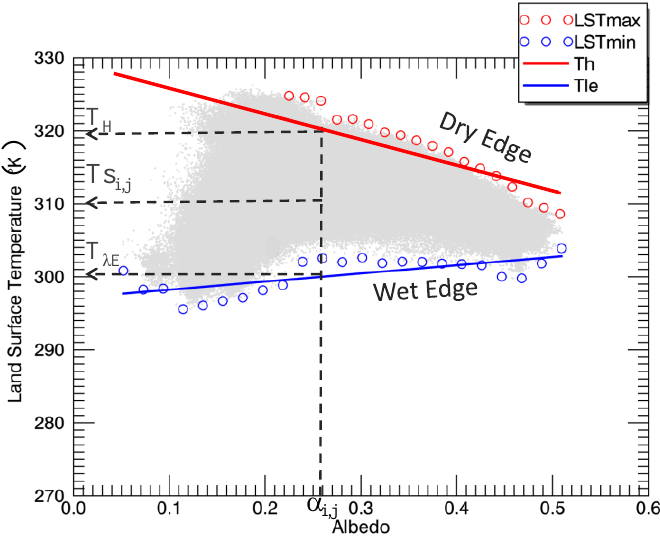
Figure 2. Scatterplot between surface albedo and LST. Blue circles correspond to minimum temperature values for each albedo class, which are used to compute the wet edge (lower limit of the graph) through linear regression. Red circles correspond to the maximum temperature values for each albedo class, which are used to compute the dry edge (upper limit) through linear regression. T (maximum temperature) and T (minimum H λE temperature) represent the values used in the calculation of the EF for the pixel i .